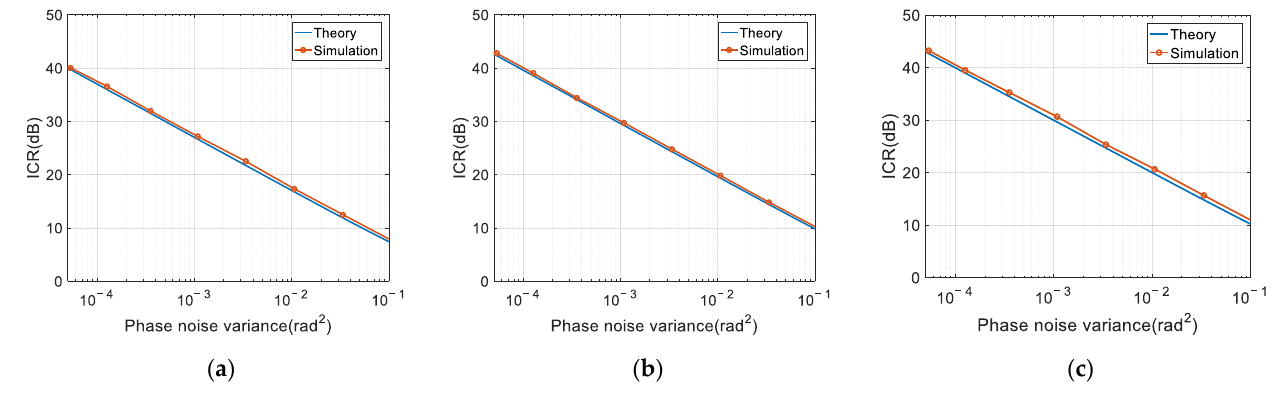
Figure 6. ICR versus phase noise variance: ( a ) N = 1; ( b ) N = 10; ( c ) N = 100.